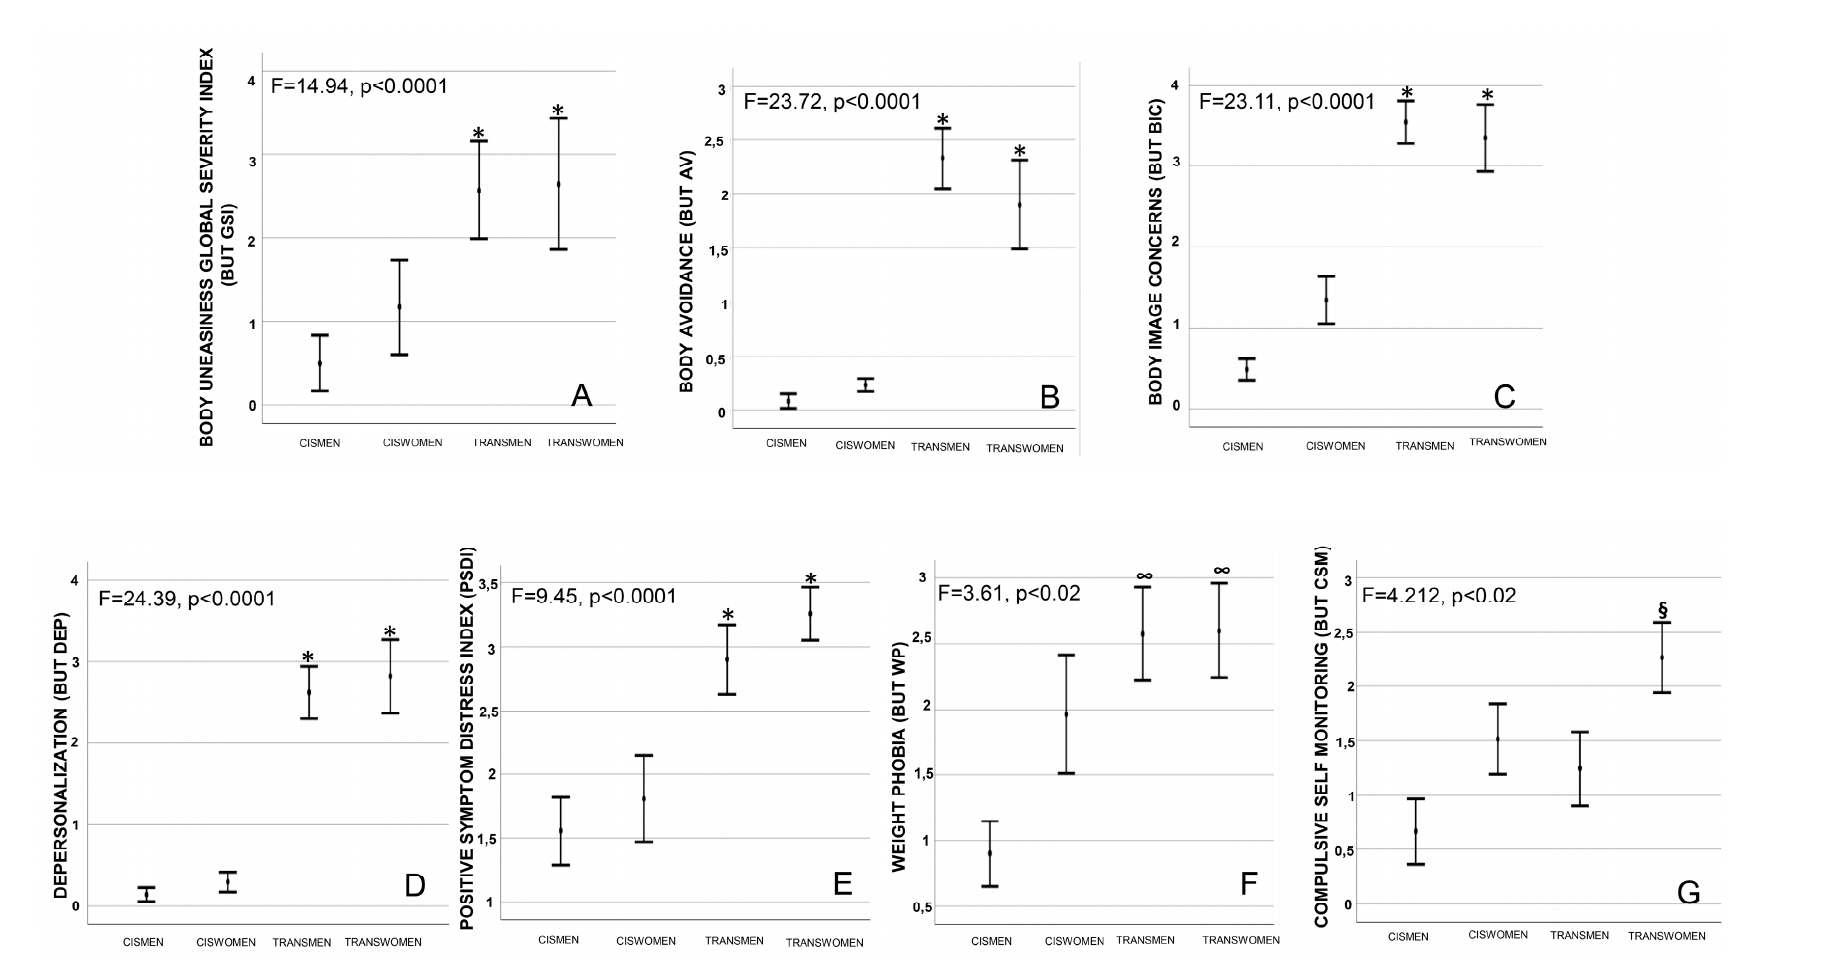
Figure 4. (A) Body uneasiness global severity index (BUT GSI), ( B ) body avoidance (BUT AV), ( C ) body image concerns (BUT BIC), ( D ) depersonalization (DEP), ( E ) positive symptom distress index (PSDI), ( F ) weight phobia (BUT WP) and ( G ) compulsive self-monitoring (BUT CSM) according to di ff erent groups as derived by ANCOVA and Post hoc Tukey’s B test after adjustment for age and body mass index. * transwomen and transmen vs. ciswomen and cismen; ∞ transwomen and transmen vs. cismen; § transwomen vs. other groups. ANCOVA = Analysis of